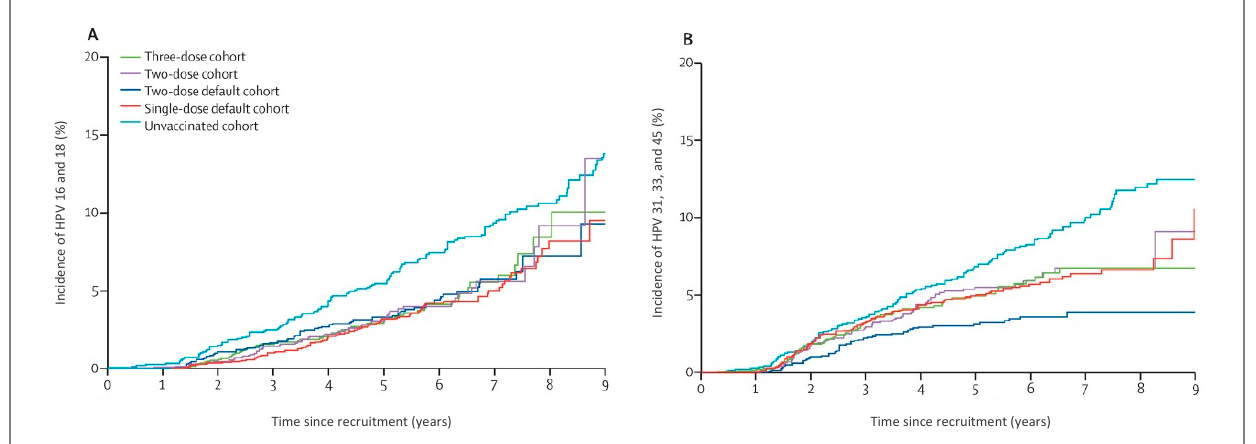
Figure 4. Incidence of HPV-16 and HPV-18 ( A ) and HPV-31, HPV-33 and HPV-45 ( B ), after one, two, three or no doses of the quadrivalent vaccine, showing similar HPV infection incidence in the one-, two- and three-dose cohorts (reproduced with permission from Basu et al. [84]).